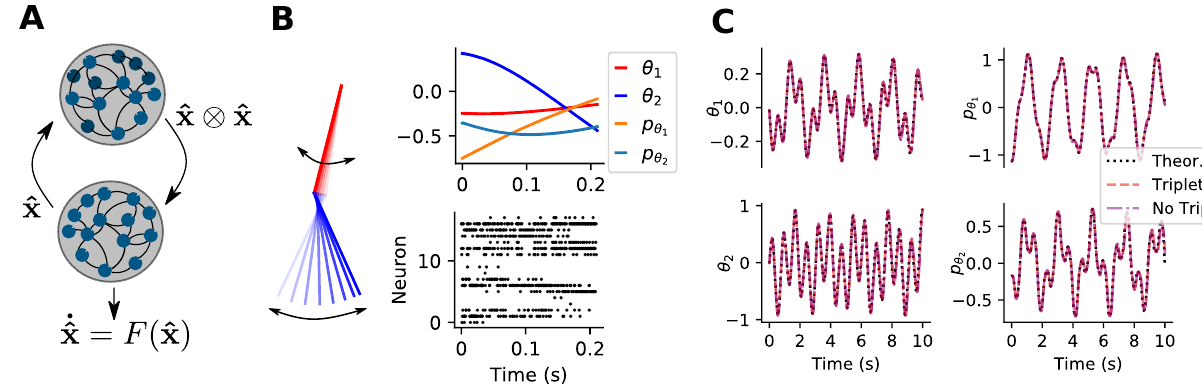
Figure 3 – Third order polynomial dynamics solved by sequential pairwise